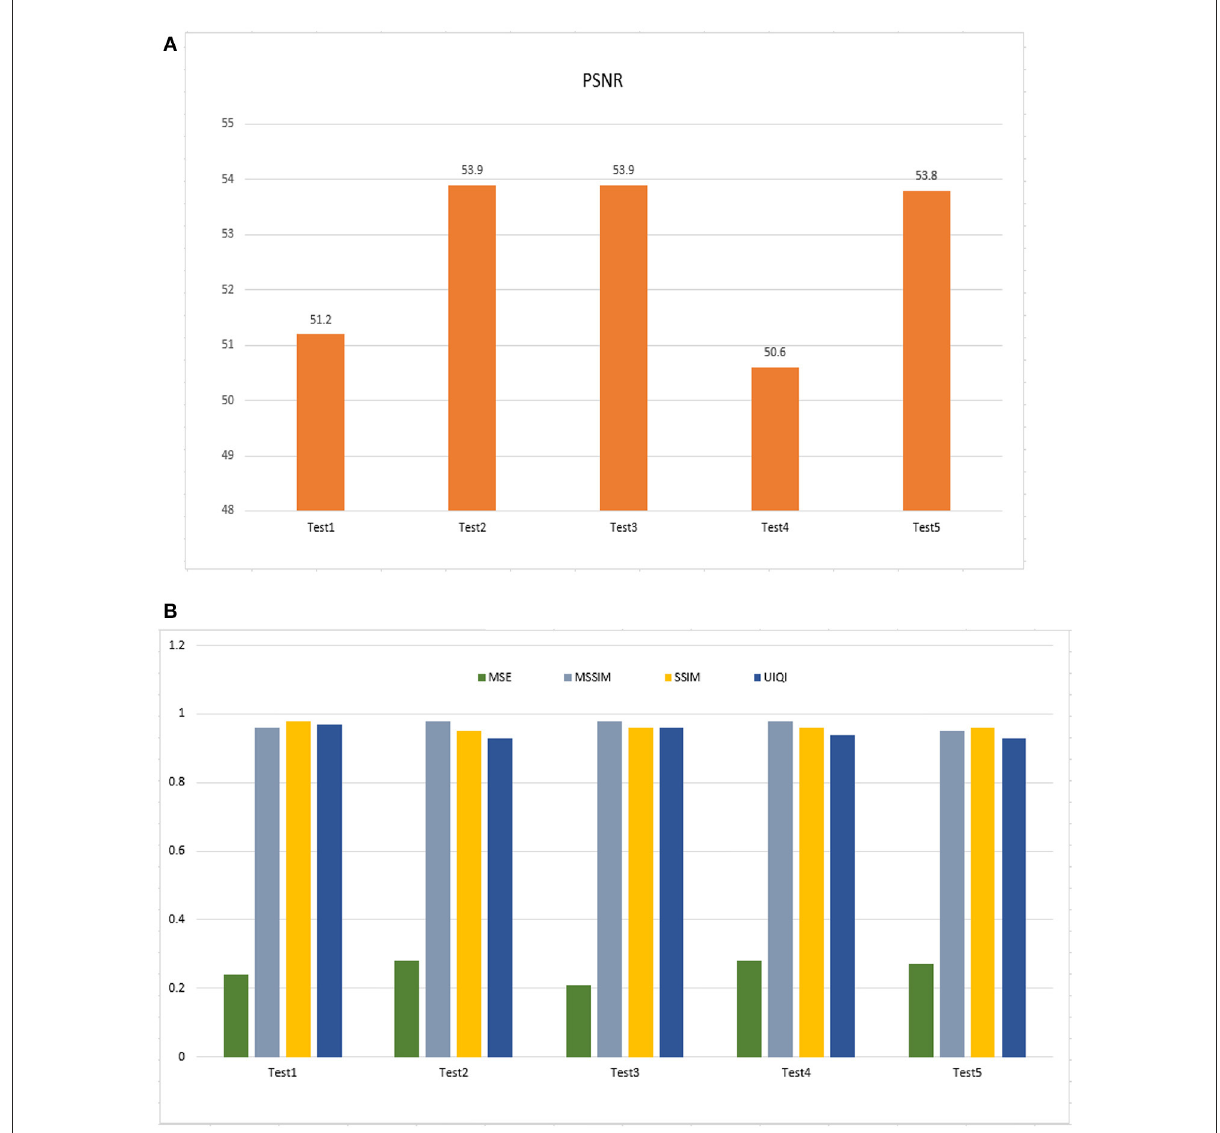
FIGURE11 (A) Performance outcome of imperceptibility (PSNR). (B) The outcome of MSE (Mean Square Error), MSSIM (Mean Structure Similarity Index Measure), SSIM (Structure Similarity Index Measure), and UIQI (Universal Index, Quality